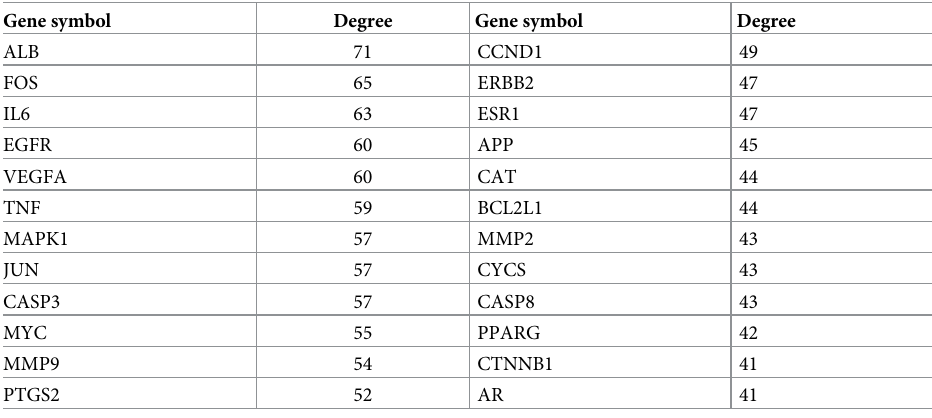
Table 2. Core targets of